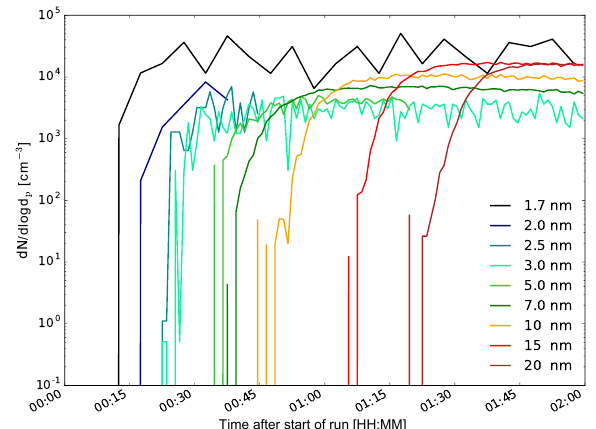
Figure 11. Time evolution of the signal in the different DMA-train channels during an α -pinene ozonolysis event in the CLOUD cham- ber. In order to cover a wider size range, some DMAs are switched to bigger sizes as soon as a steady state is reached. The clear subse- quent appearance of the signal in the different channels verifies the size calibration and allows for the determination of particle growth